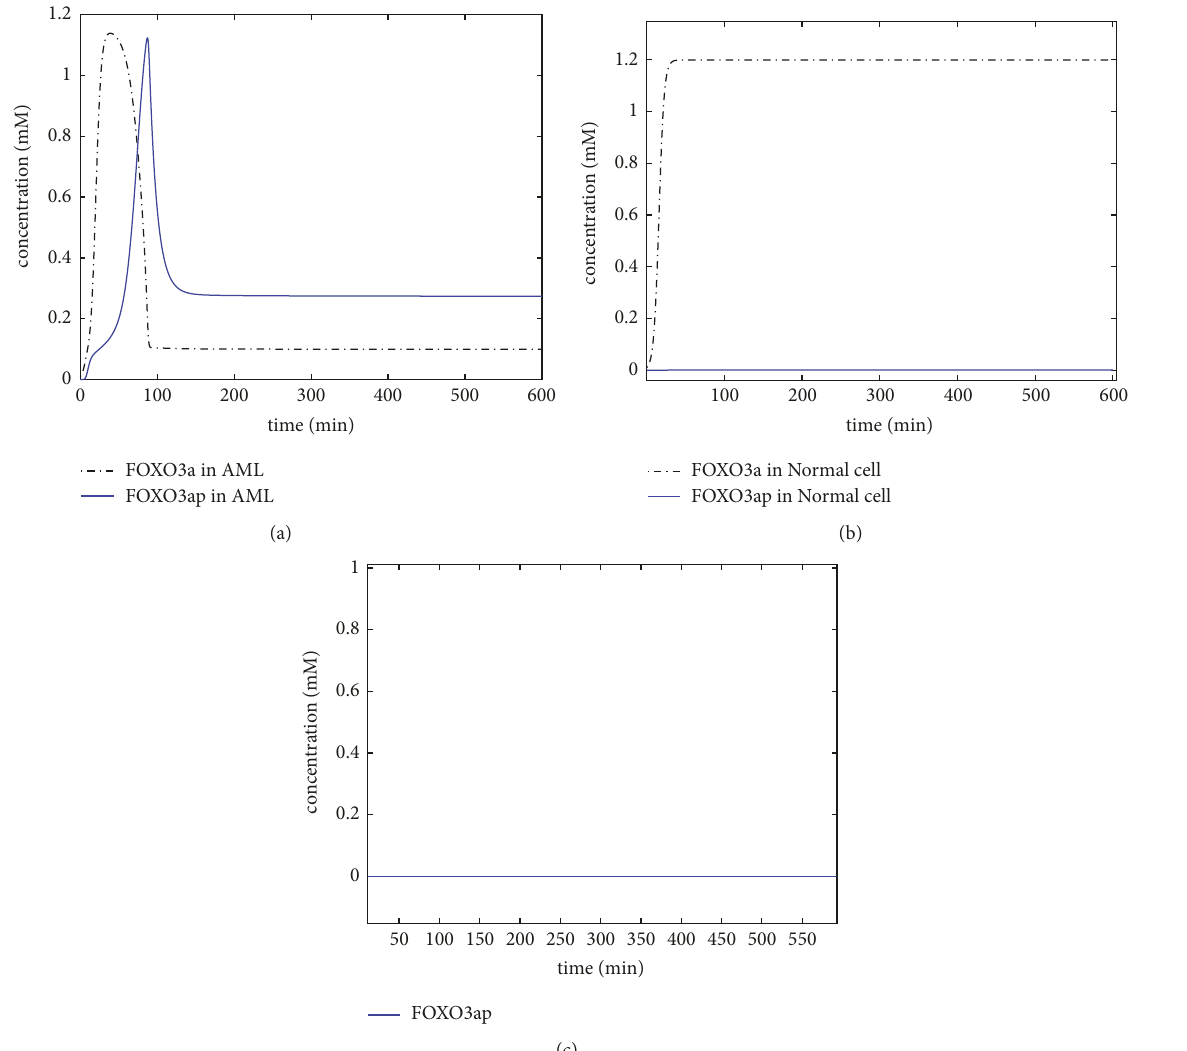
Figure2:DynamicofFOXO3aandFOXO3apconcentrationinAMLcell(a),dynamicofFOXO3aandFOXO3apconcentrationinthenormal cell (b), and FOXO3ap concentration in the absence of FOXO3a phosphorylation